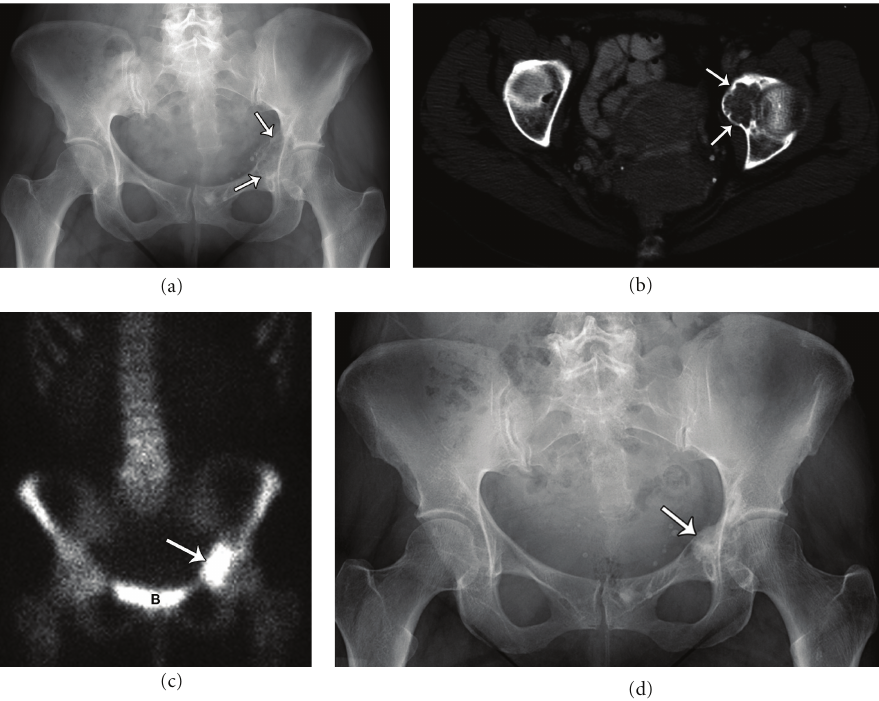
Figure 7: Forty-six-year-old female with a lytic lesion in the left medial acetabulum, diagnosed as chondroblastoma. Plain film (a) and axial CT (b) demonstrating a lytic lesion with heterogeneous chondroid matrix and sharp scalloped margins. The tumor showed increased uptake on bone scan (c) (B: bladder). Plain film (d) demonstrating healed chondroblastoma following surgical curettage and cement